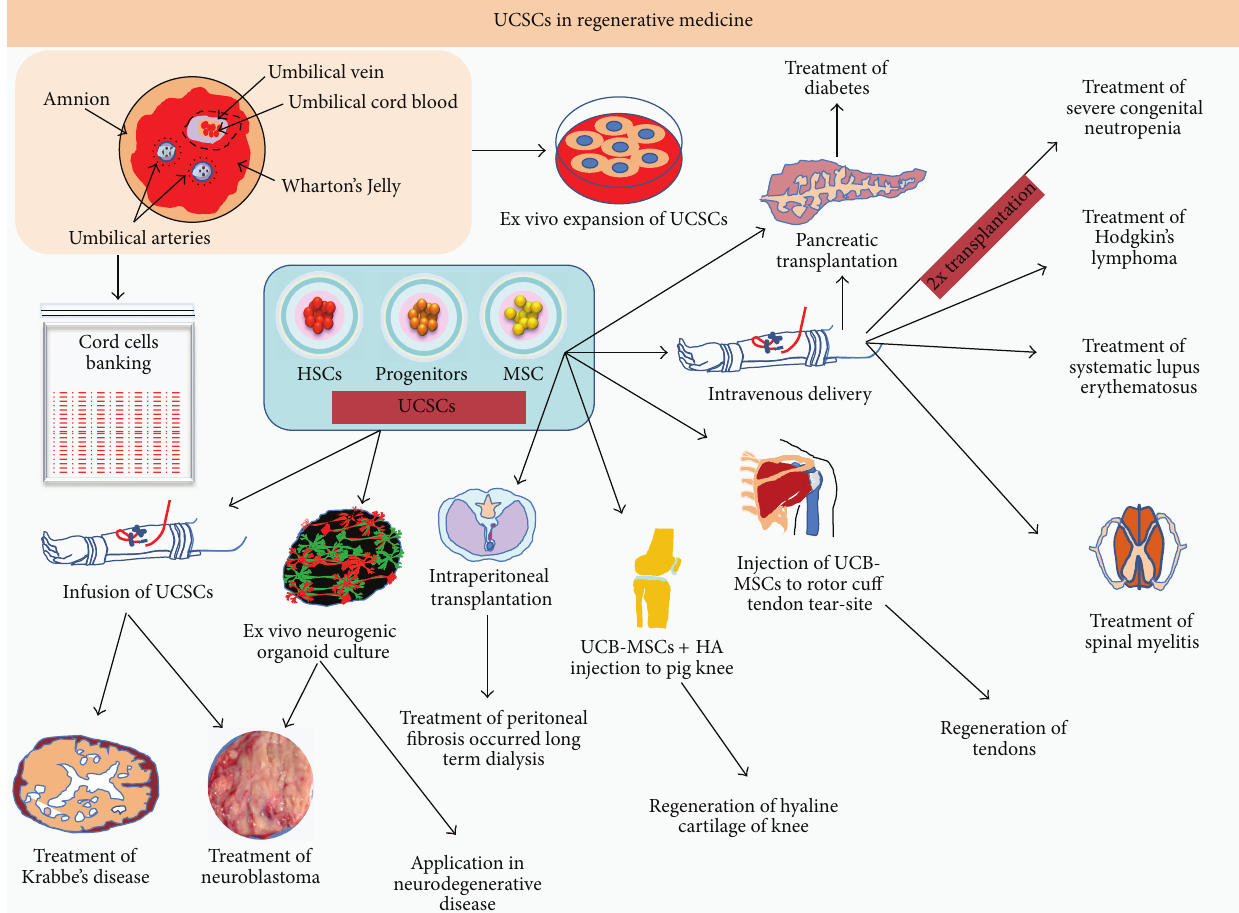
Figure 5: UCSCs in regenerative medicine: umbilical cord, the readily available source of stem cells, has emerged as futuristic source for personalized stem cell therapy. Transplantation of UCSCs to Krabbe’s disease patients regenerates myelin tissue and recovers neuroblastoma patients through restoring tissue homeostasis. The UCSCs organoids are readily available tissue source for treatment of neurodegenerative disease. Peritoneal fibrosis caused by long term dialysis, tendon tissue degeneration, and defective hyaline cartilage can be regenerated by UCSCs. Intravenous injection of UCSCs enables treatment of diabetes, spinal myelitis, systemic lupus erythematosus, Hodgkin’s lymphoma, and congenital neuropathies. Cord blood stem cells banking avails long lasting source of stem cells for personalized therapy and regenerative